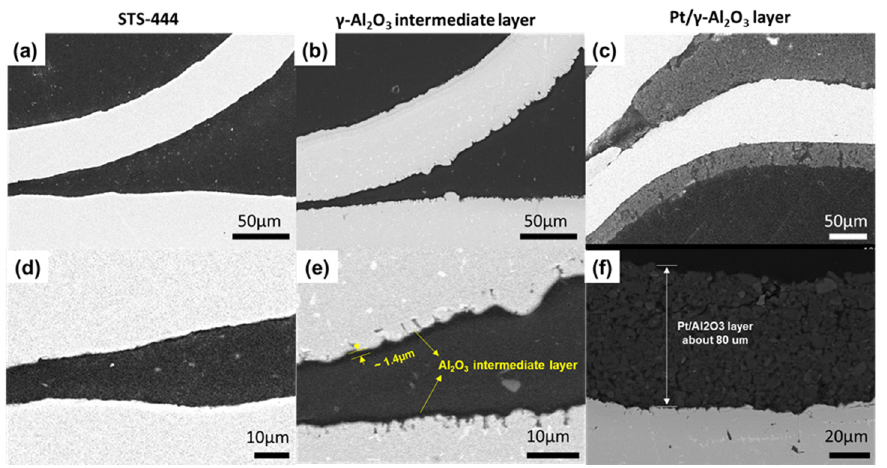
Figure 2. SEM images of the bare STS-444 substrate ( a , d ), γ -Al 2 O 3 intermediate layer ( b , e ), and Pt/Al 2 O 3 catalyst layer ( c , f